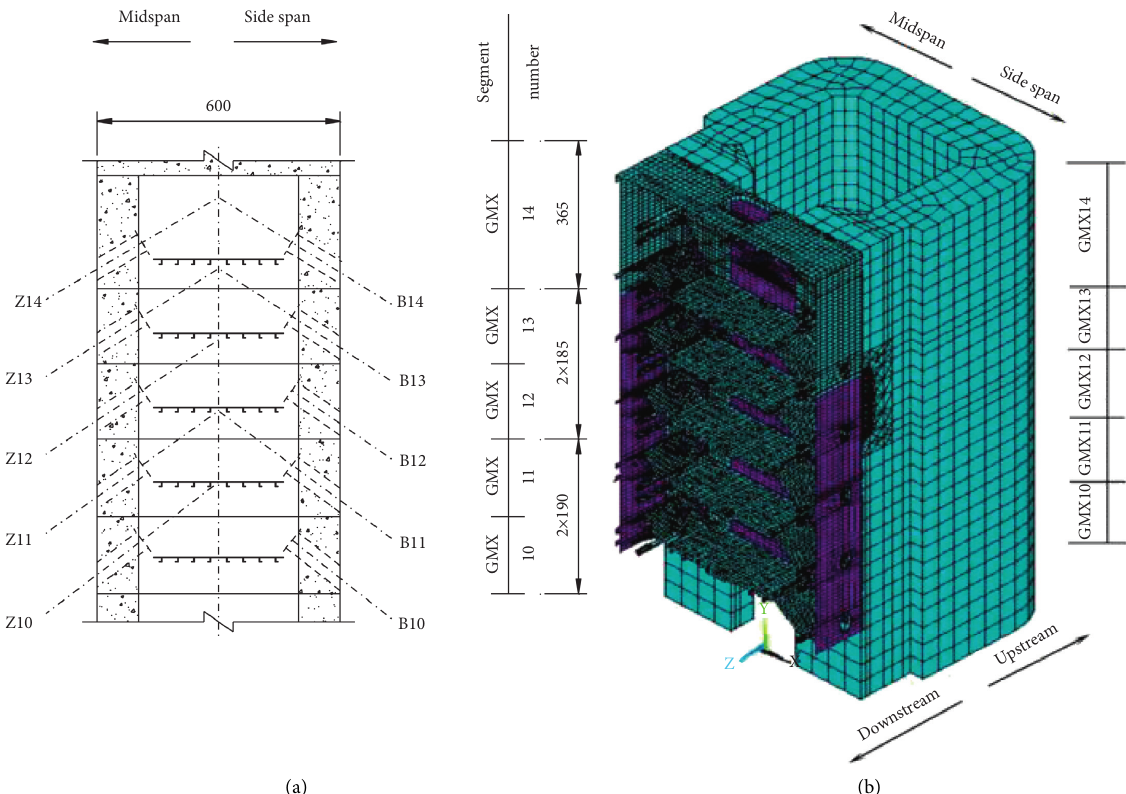
Figure 2: Finite element model of the anchorage structure. (a) Elevation of the anchorage structure of top 5 segments of the tower column. (b) Finite element model.